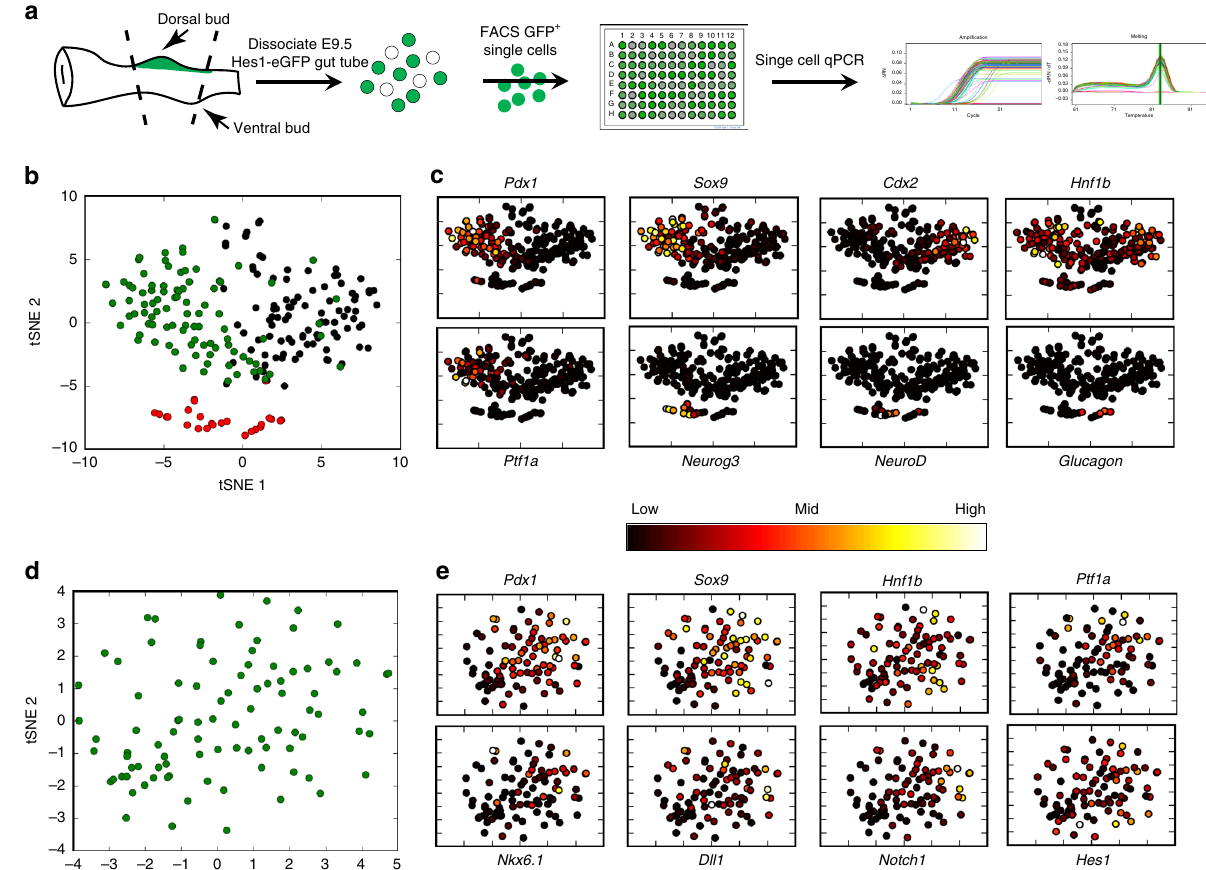
Fig. 2 Single-cell qRT-PCR of E9.5 pancreatic progenitors reveals endocrine differentiation progression but no apparent tip-trunk segregation signature. a Schematic outline of the strategy used to isolate single pancreatic progenitor cells for single-cell qRT-PCR analysis using the Hes1-eGFP strain 43 . b tSNE dimensionality reduction of all single cells passing initial quality controls. Three cell clusters are displayed in green , black and red , corresponding to pancreatic progenitors, duodenal progenitors and pancreatic endocrine cells, respectively. c Hnf1b is expressed in both pancreatic and duodenal progenitors, whereas Ptf1a expression is exclusively detected in pancreatic progenitors albeit in heterogeneous pattern. Cells in the endocrine population cluster organise on a pseudo-temporal differentiation pathway starting with Neurog3 + endocrine precursors at the left, progressing into glucagon-expressing terminally differentiated endocrine cells at the right. d tSNE dimensionality reduction of Pdx1 + pancreatic progenitors only. e Despite heterogeneous expression of transcription factors and signalling components involved in subsequent tip-trunk segregation, expression of these markers seems uncorrelated and does not partition Pdx1 + progenitors into tip- and trunk-biased